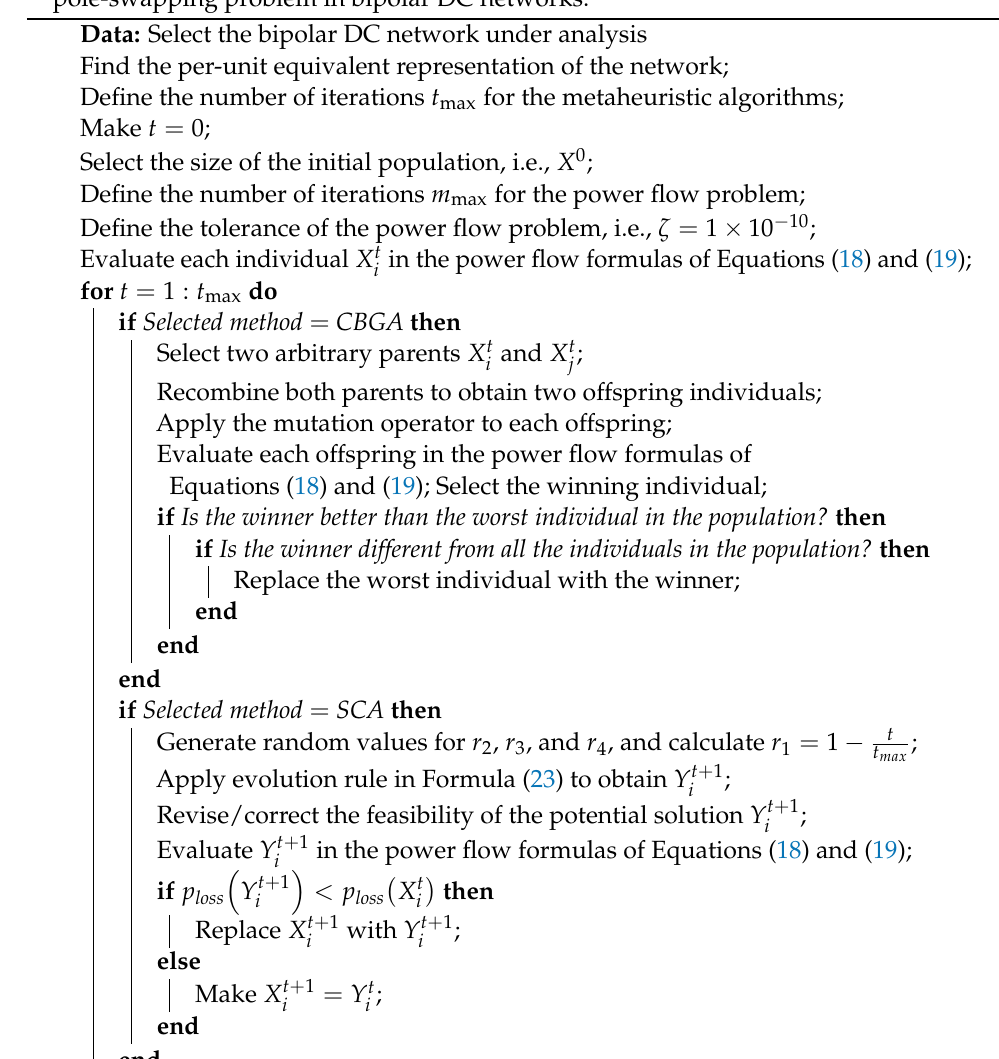
Algorithm 1: Proposed master–slave optimization approach to solve the optimal pole-swapping problem in bipolar DC